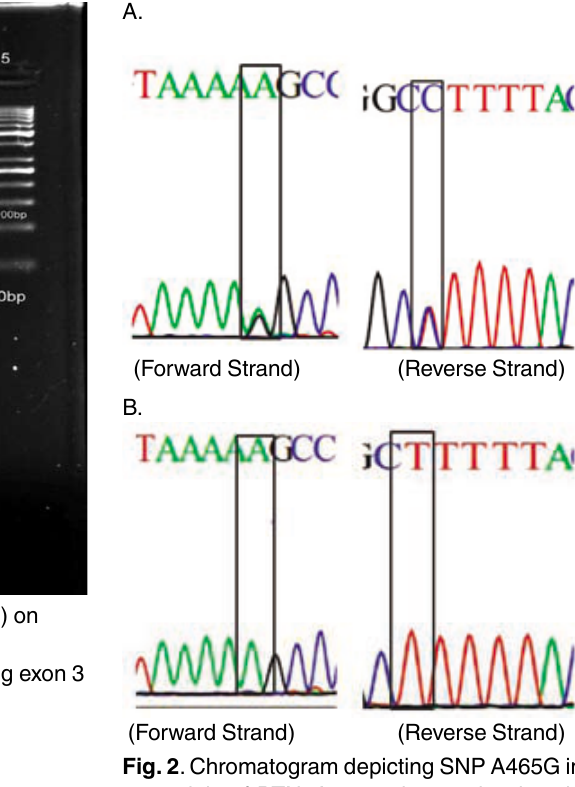
Fig. 2 . Chromatogram depicting SNP A465G in exon eight of BTN1A1 gene in crossbred cattle of Kerala. A and B – Chromatogram depicting KL and KK genotypes, respectively